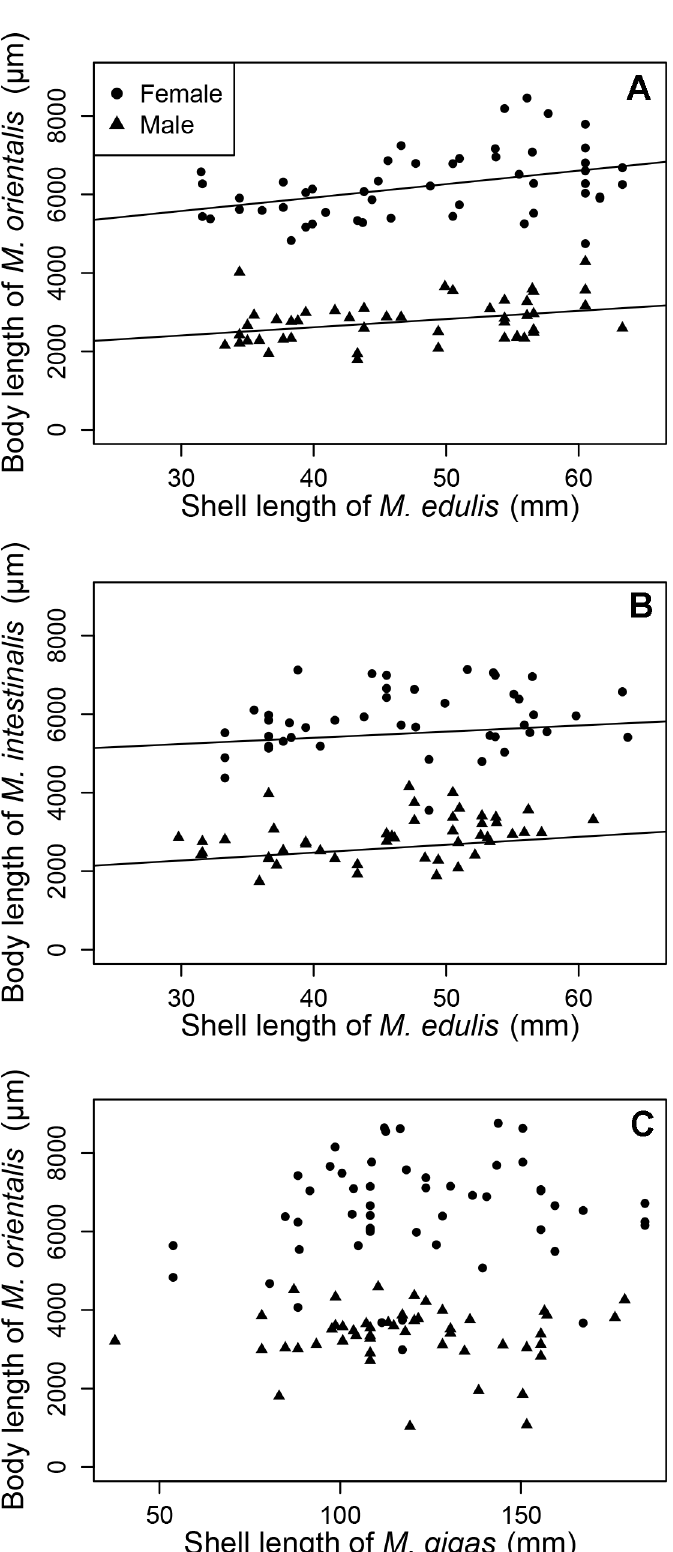
Fig 4. Relationship between host shell length (mm) and parasite body length (μm) per sex for each Mytilicola -host species combination. (A) M . orientalis in blue mussels ( Mytilus edulis ). (B) M . intestinalis in blue mussels. (C) M . orientalis in Pacific oysters ( Magallana gigas ). Fitted lines are significant